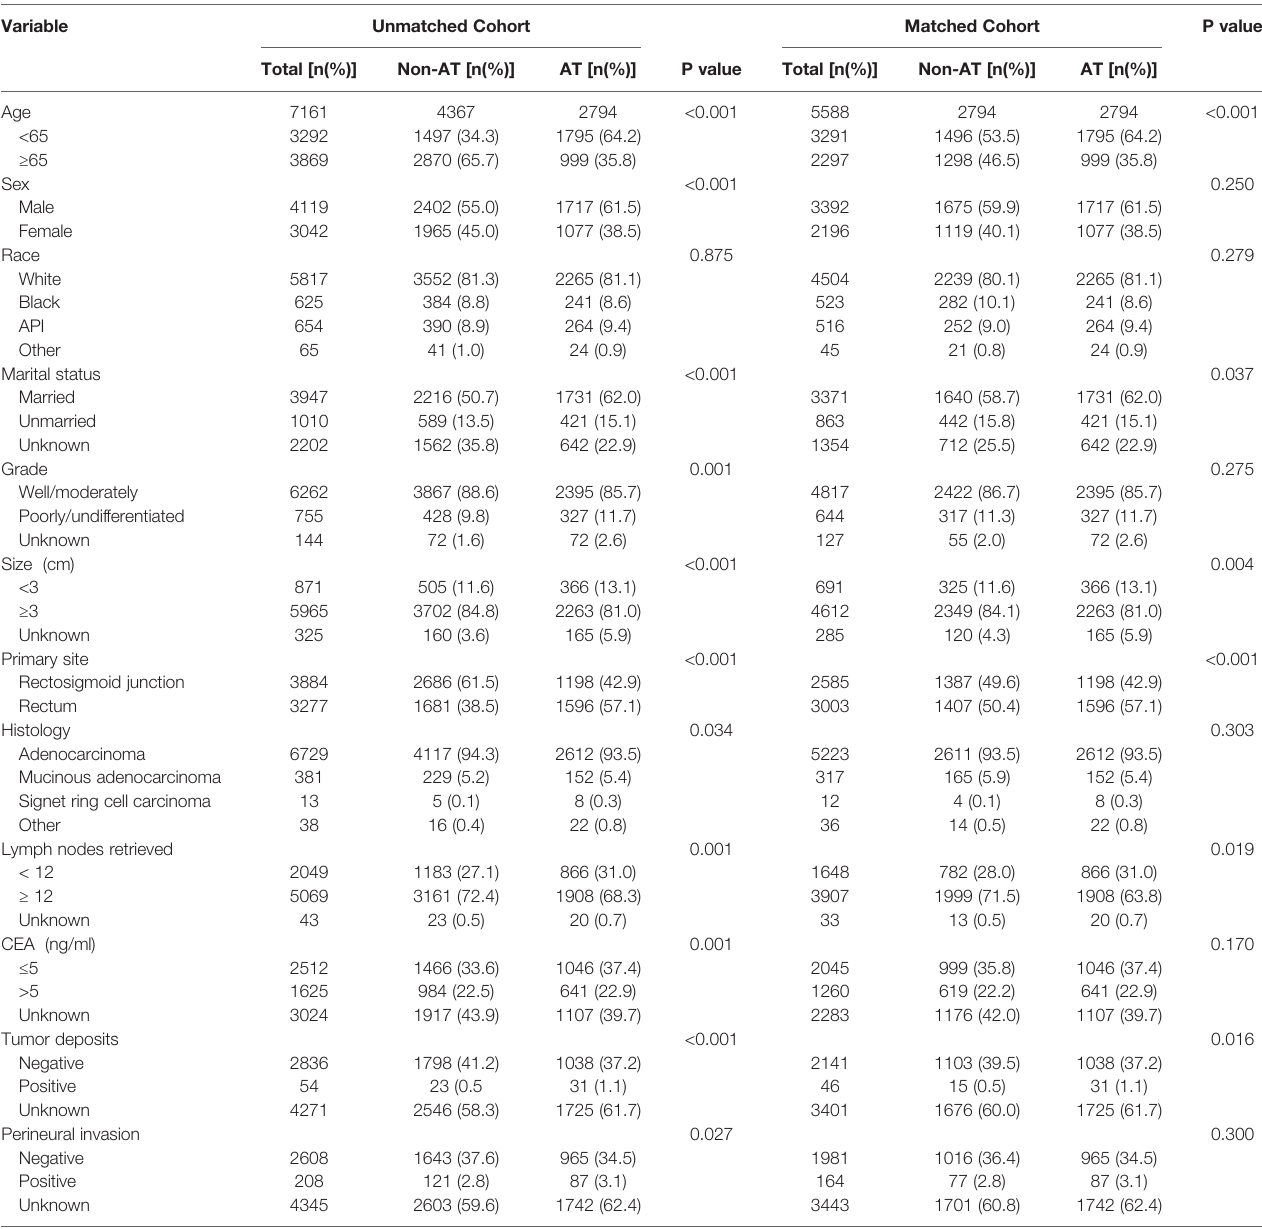
TABLE 1 | Characteristics of patients.